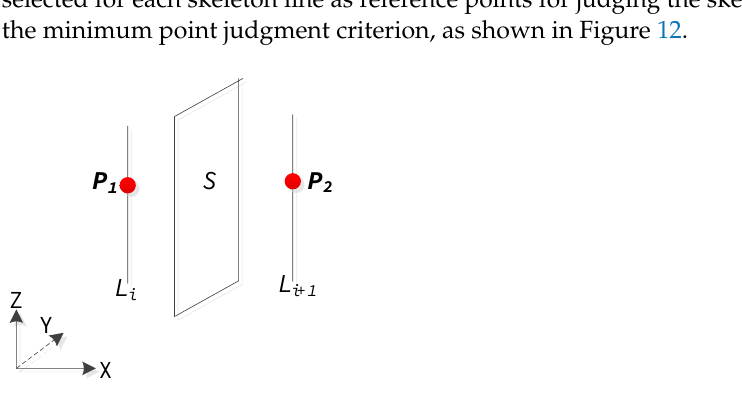
Figure 12. Judgment of the relative position of the flow channel